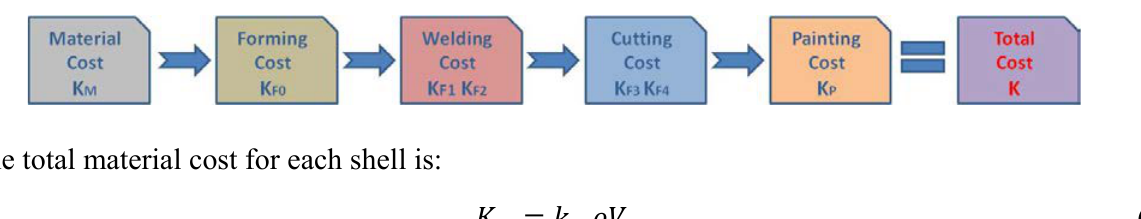
Figure 2. Cost function for the wind turbine